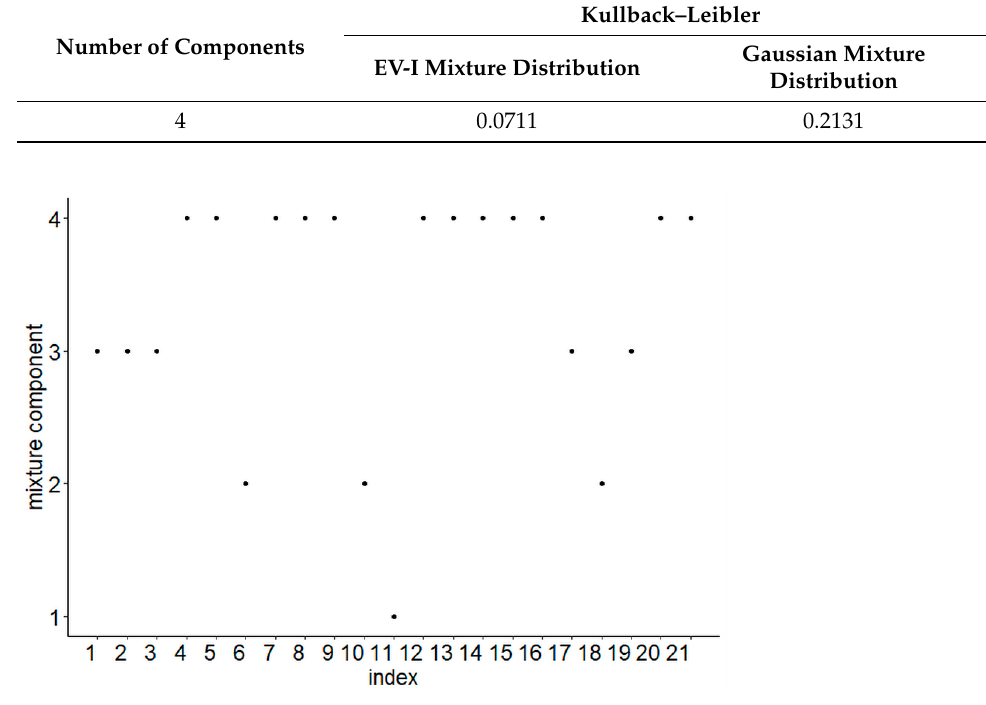
Figure 10. Membership label of each observation on the DHF data in eastern Surabaya using the EV-I mixture distribution with four components.